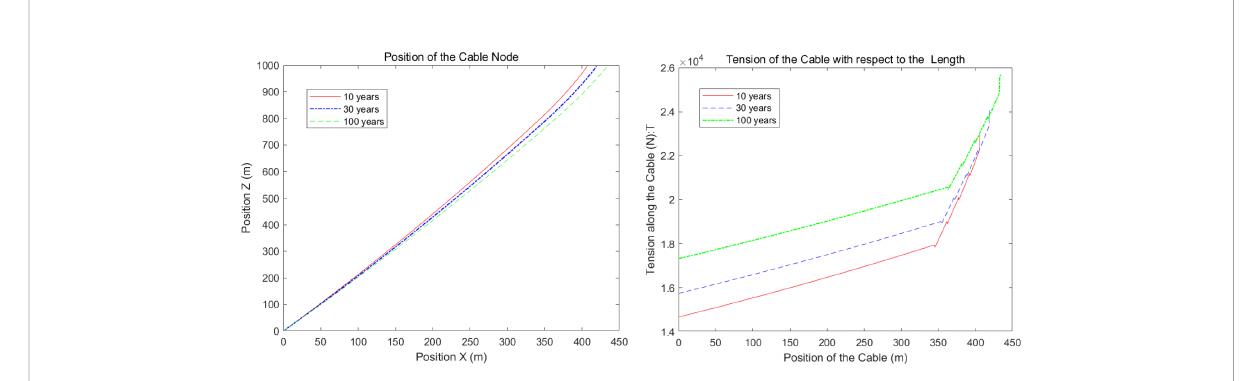
FIGURE8 Shape of the mooring line and mooring tension for a Nilspin EM cable with the snubber up for different